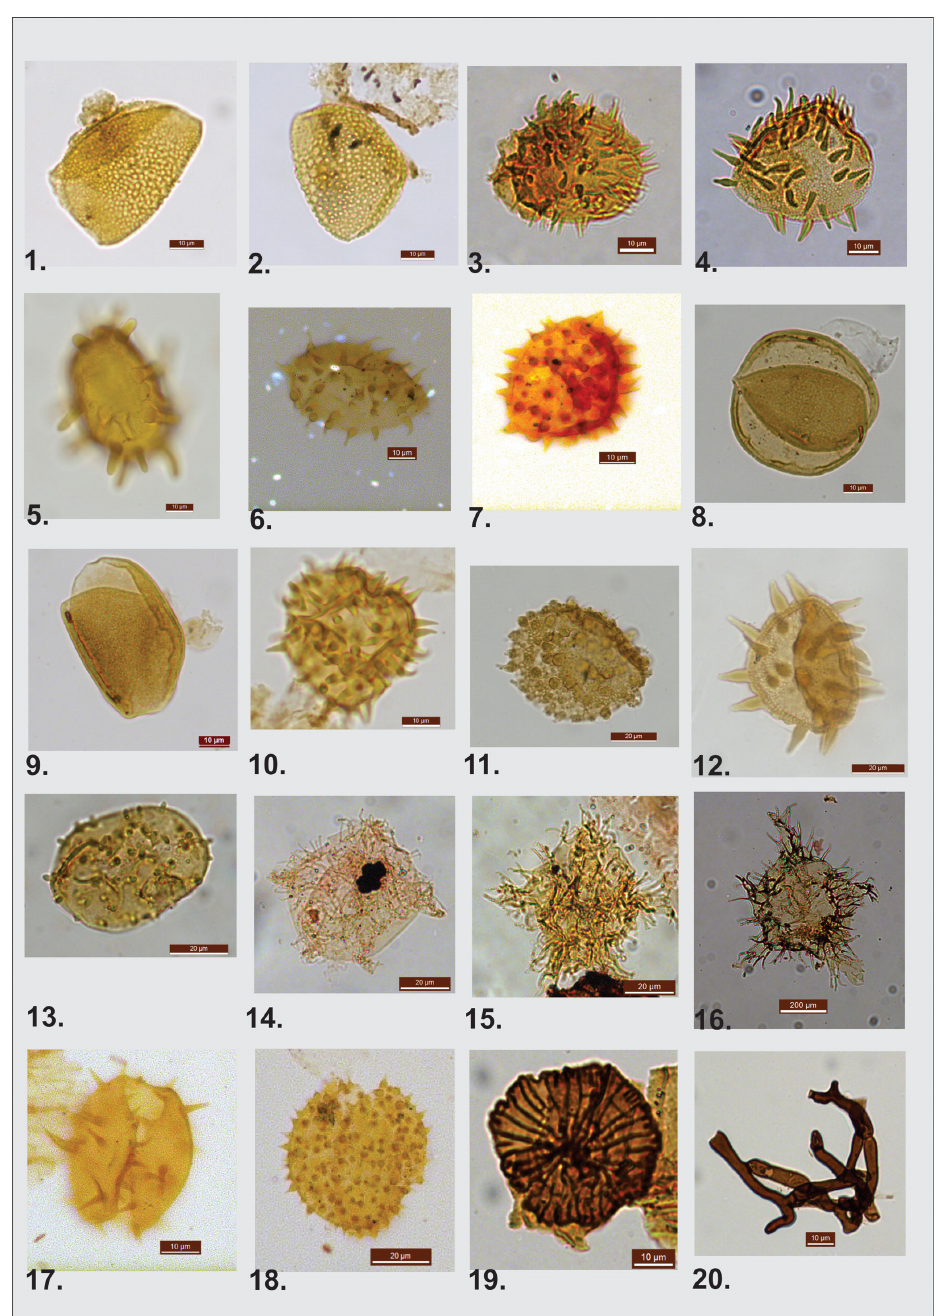
Plate 1. The palynomorph assemblage from Early Eocene sections: panels (1) and (2) are Longapertites retipilatus . Panels (3) , (4) and (5) are Spinizonocolpites prominatus . Panels (6) and (7) are Spinizonocolpites bulbospinosus . (8) Proxapertites microreticulatus . (9) Longapertites retipilatus . (10) Acanthotricolpites bulbospinosus . (11) Kapurdipollenites gemmatus . (12) Spinizonocolpites baculatus . (13) Spinizonocol- pites brevispinosus . (14) Apectodinium quinquelatum . (15) Apectodinium paniculatum . (16) Apectodinium paniculatum . (17) Arengapollen- ites achinatus . (18) Acanthotricolpites kutchensis . Panels (19) and (20) are fungal